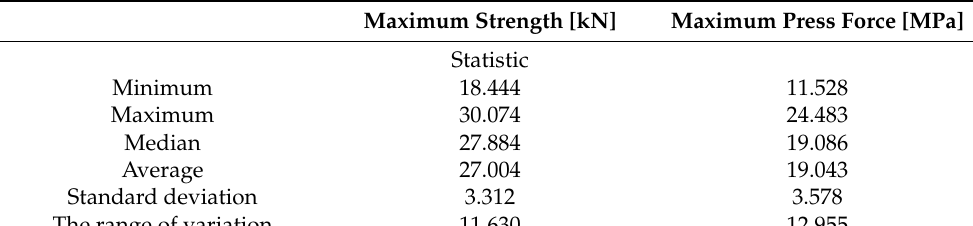
Table 16. Compressive strength tests for basalt dust A for all samples for water − mix ratio = 0.7.